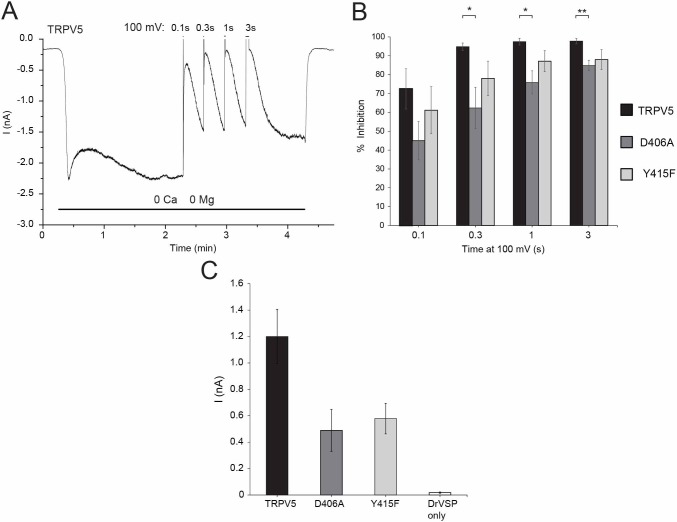
The effect of reducing PI(4,5)P2 levels with a voltage sensitive phosphatase on wild type and mutant TRPV5 channels.HEK293 cells were transfected with drVSP and TRPV5 or its mutants. Whole cell patch clamp recordings were performed as described in the methods section; the membrane potential was clamped at −80mV. drVSP is inactive at −80 mV, once it is activated by depolarizing membrane potentials, it removes the 5’ phosphate from PI(4,5)P2. (A) Representative current trace in cells transfected with drVSP and wild type rbTRPV5, depolarizing pulses to 100 mV were applied to activate drVSP. (B) Summary of inhibition by the different length depolarization pulses for wild type and the D406A and the Y415F mutants of TRPV5. Statistical significance was calculated with two-way analysis of variance, inhibition of the wild type TRPV5 was significantly different from that of the D406A mutant (p=0.00037), but not from the Y415F mutant (p=0.137) with Tukey’s post hoc test. In the figure, statistical difference was also calculated by uncorrected t-test at individual depolarization lengths, *p<0.05, **p<0.01, (C) Summary of raw current amplitudes (n = 6–8).